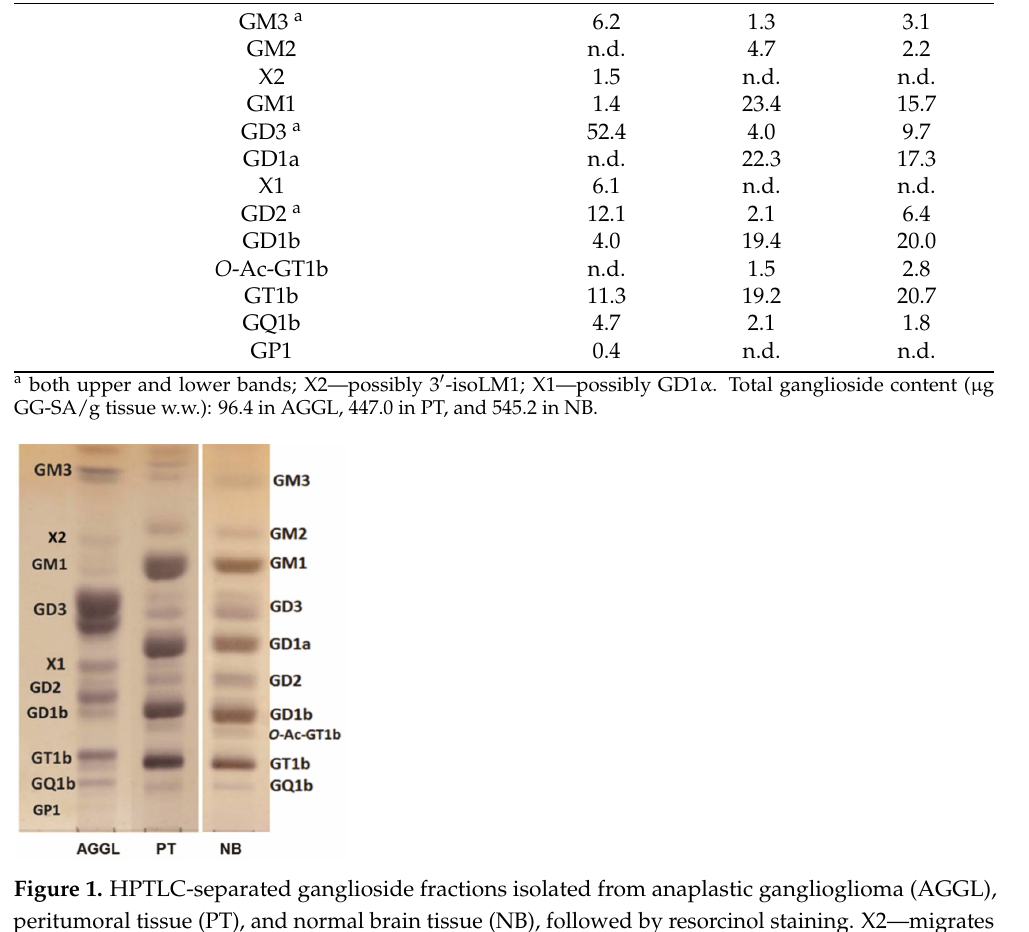
Table 1. Relative proportions of HPTLC-separated GG fractions from anaplastic ganglioglioma (AGGL), peritumoral tissue (PT), and normal brain tissue (NB). Ganglioside Fractions (%) Migrating as: AGGL PT